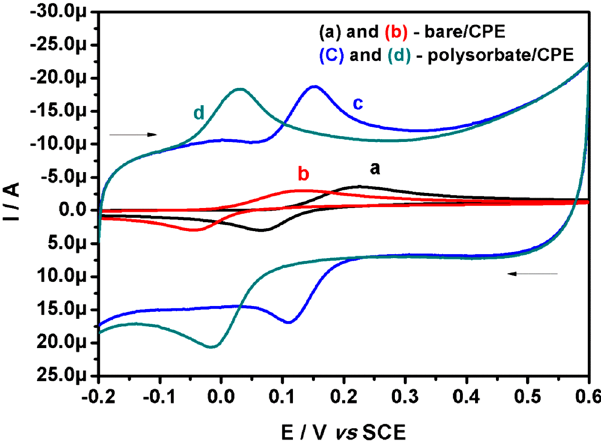
Figure 4. CVs of 20.0 μM CC (curve a ) and 20.0 μM HQ (curve b ) at bare/CPE, the improved CVs observed at polysorbate/CPE for CC (curve c ) and HQ (curve d ) in buffer (0.2 M PBS; pH 7.4) with 0.05 Vs −1 scan rate.